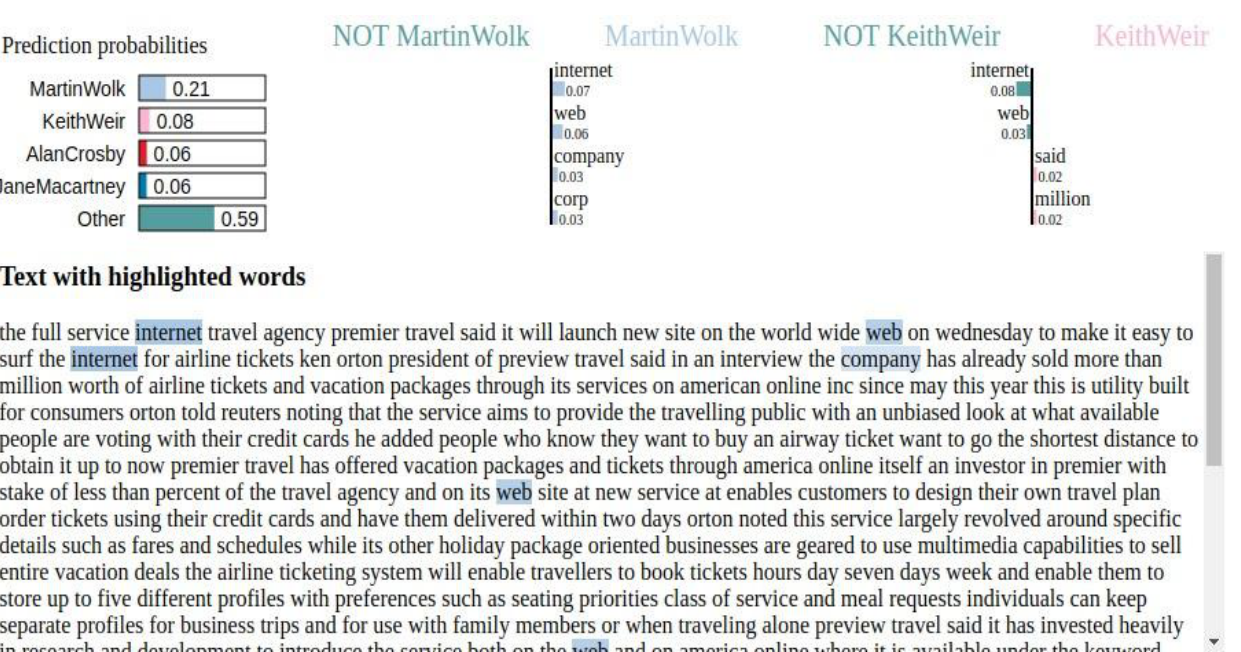
Figure 7. Explanation of individual prediction of the proposed method on the CCAT50 document using LIME.